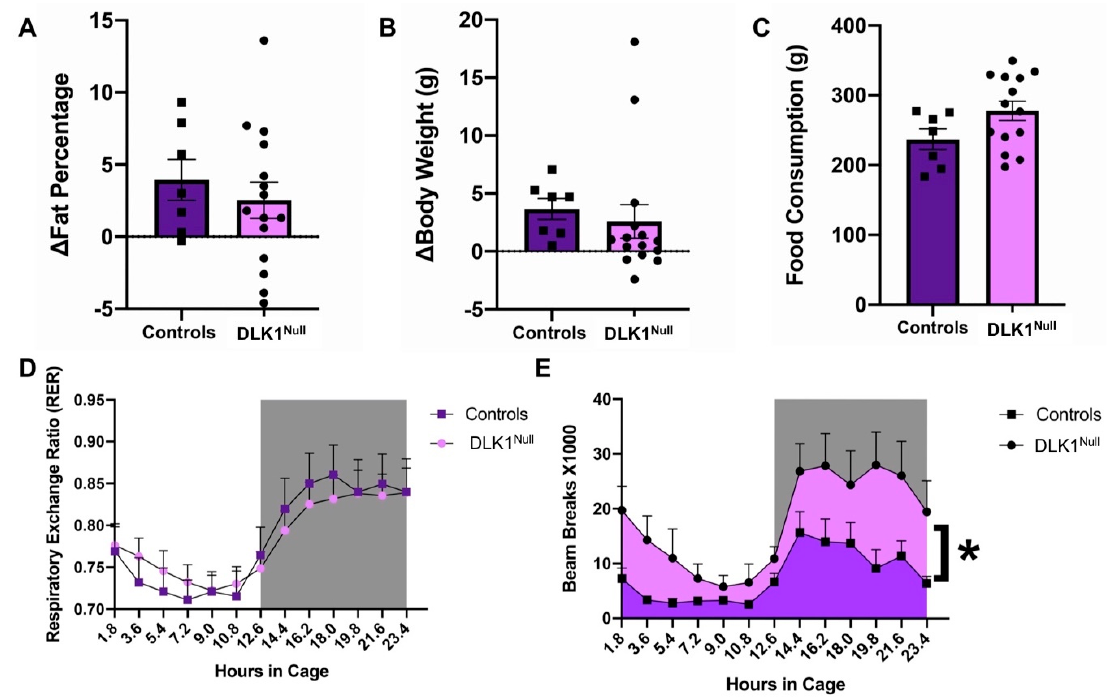
Figure 5. DLK1-deletion in the LHA increases locomotor activity but does not alter energy balance. Control and DLK1 Null mice exhibited similar ( A ) change ( ∆ ) in total body fat percentage, ( B ) body weight and ( C ) the grams of food consumed over 8 weeks. ( D ) Control and DLK1 Null mice had similar RER over the light / dark cycle. ( E ) Area under the curve analysis indicates that DLK1 Null mice exhibit more ambulatory locomotor activity in metabolic cages than Control mice, * p < 0.05. For ( D , E ), gray shading identifies the dark cycle. Control n = 7, DLK1 Null = 15.